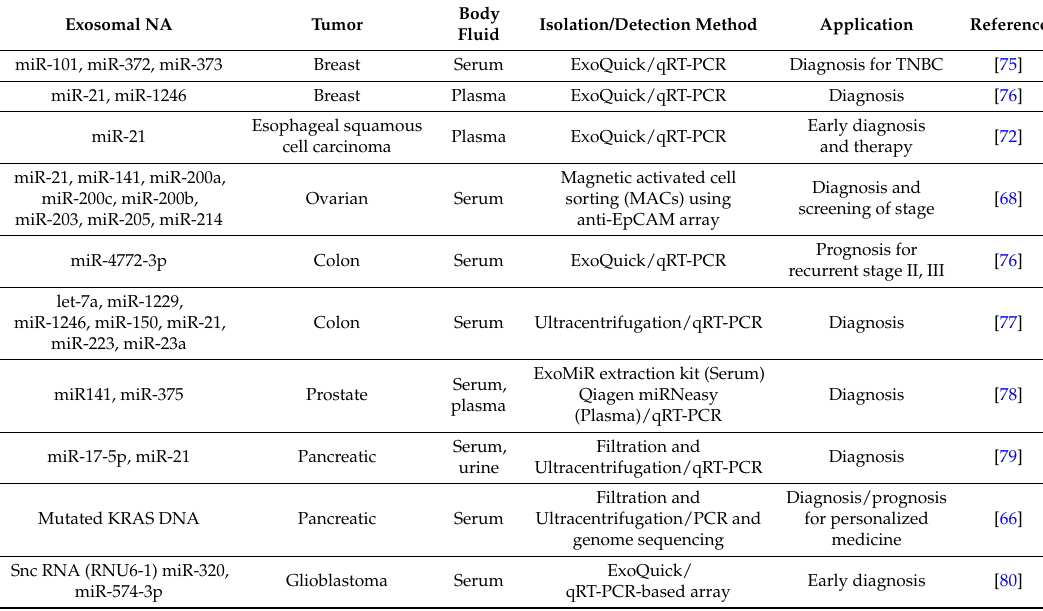
Table 2. Exosomal nucleic acid biomarkers in pre-clinical and clinical